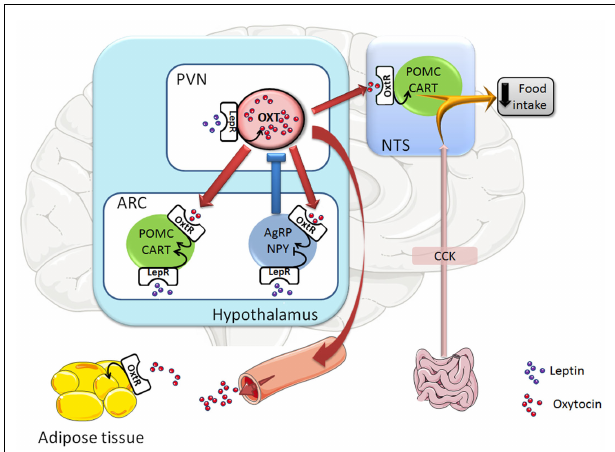
FIGURE 1 | Representative scheme of the oxytocin neuronal circuits controlling food intake . Leptin, through the leptin receptor (LepR), activates oxytocin (Oxt) neurons in the hypothalamic paraventricular nucleus (PVN) and POMC/CART neurons in the hypothalamic arcuate nucleus (ARC), whereas it inhibits AgRP/NPY neurons in the ARC. Once oxytocin neurons are activated, they are innervating and activating POMC/CART neurons in the hypothalamic ARC nucleus and the hindbrain NTS nucleus (which is receiving also innervation from the gut), leading to a decrease in food intake. Moreover, activation of oxytocin neurons also triggers a negative feedback loop as PVN oxytocin neurons innervate AgRP/NPY neurons in the ARC nucleus, which inhibit oxytocin neurons in the PVN. At last, oxytocin neurons innervate the posterior pituitary and their activation leads to the secretion of oxytocin into the circulation, a way by which oxytocin can reach its target tissues, such as white adipose tissue. Arrow-headed lines and bar-headed lines indicate activation and inhibition, respectively. Oxytocin neurons and innervations are drawn in red, POMC/CART neurons in green, AgRP/NPY neurons in blue, leptin protein in purple circles, and oxytocin protein in red circles. Abbreviations: Oxt, oxytocin; POMC, pro-opiomelanocortin; CART, cocaine- and amphetamine-regulated transcript; AgRP, agouti-related protein; NPY, neuropeptide Y; CCK, cholecystokinin; LepR, leptin receptor; OxtR, oxytocin receptor; ARC, arcuate nucleus; PVN, paraventricular nucleus; NTS, nucleus of the solitary